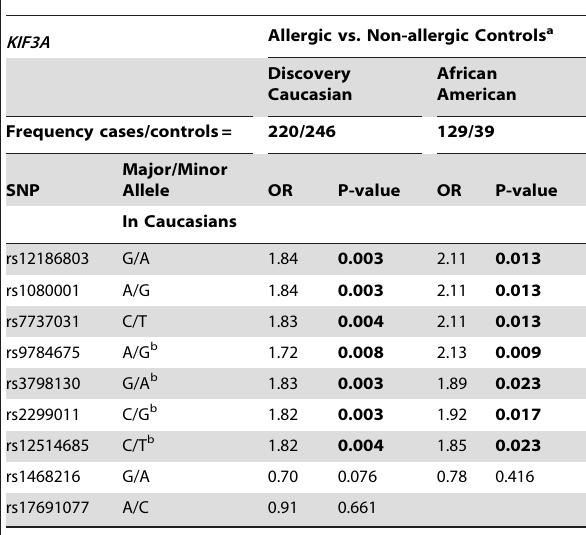
Table 5. KIF3A SNP associations with allergic disease.